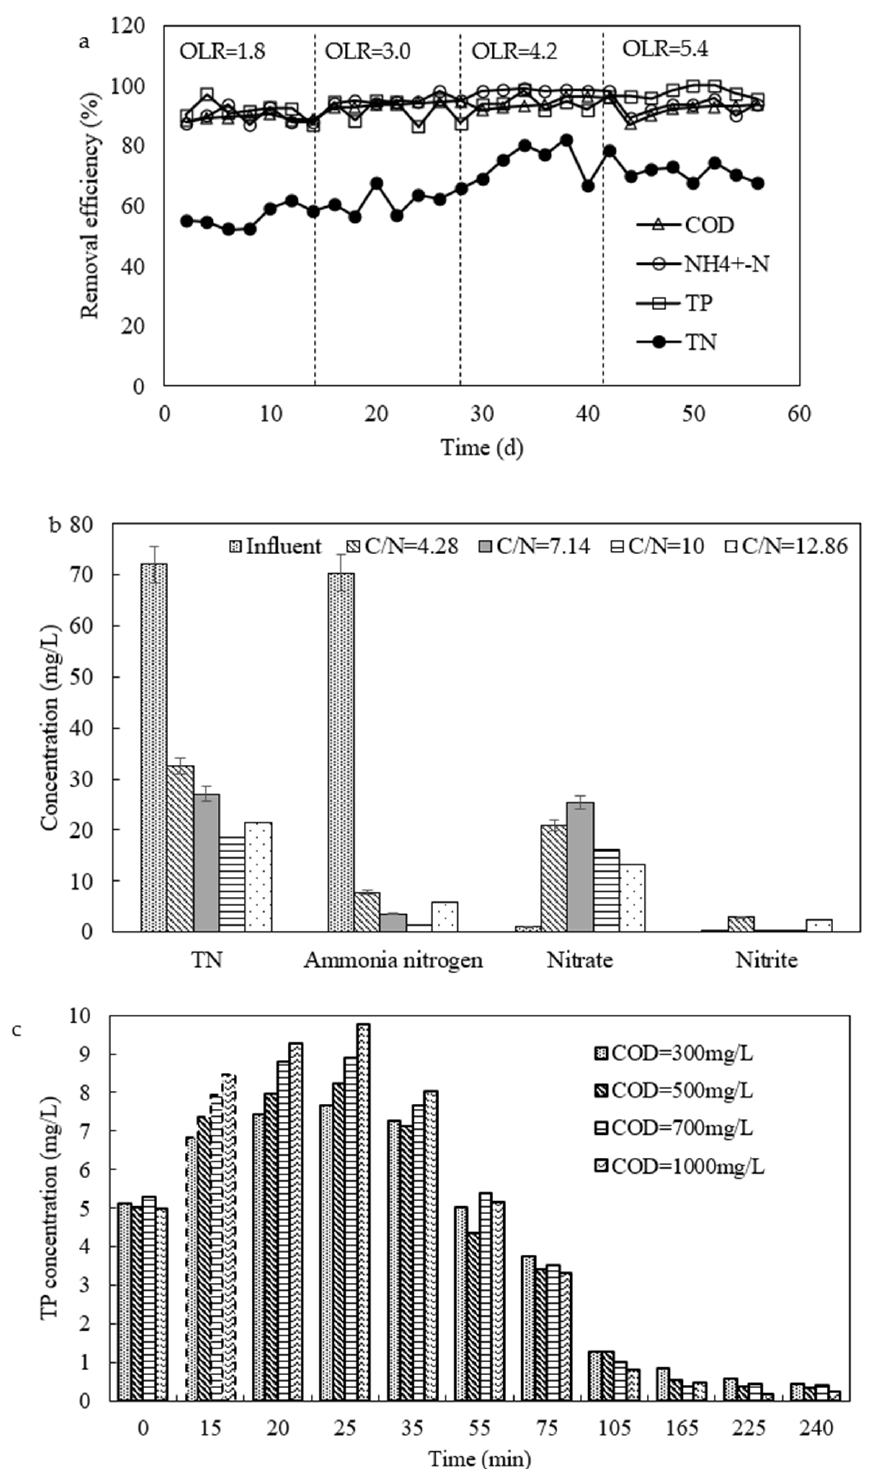
Figure 3. Effects of different organic loadings on COD removal, ammonia nitrogen removal, total nitrogen removal and phosphorus removal (the OLR unit is kg COD/m 3 · d). ( a ) pollutant removal efficiency; ( b ) pollutant concentration in the effluent; ( c ) TP concentration variation in the effluent with the variation of influent